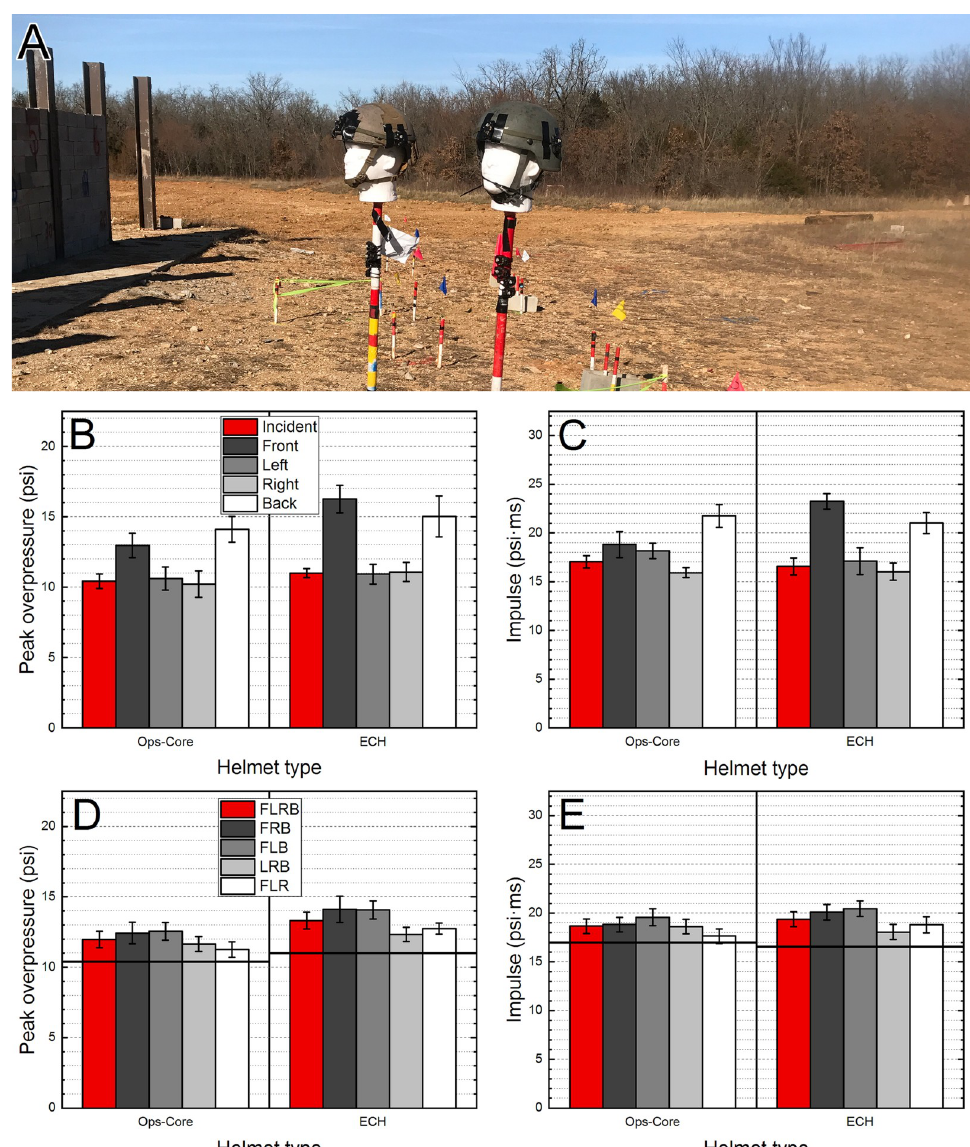
Fig 7. The field validation tests were performed at the heavy wall breaching exercise using two headforms mounted on range poles and retrofitted with Ops-Core and ECH (A, left and right, respectively). The same sensoring scheme as for shock tube testing was used. The quantification of the peak overpressure (B) and impulse (C) is presented, with a complementary analysis of the four and three sensor averages for peak overpressure (D) and impulse (E), respectively. For sensor notations refer to the text and Fig 5. The horizontal black line indicates the incident peak overpressure (or impulse) calculated as an average of two sensors: LEFT and